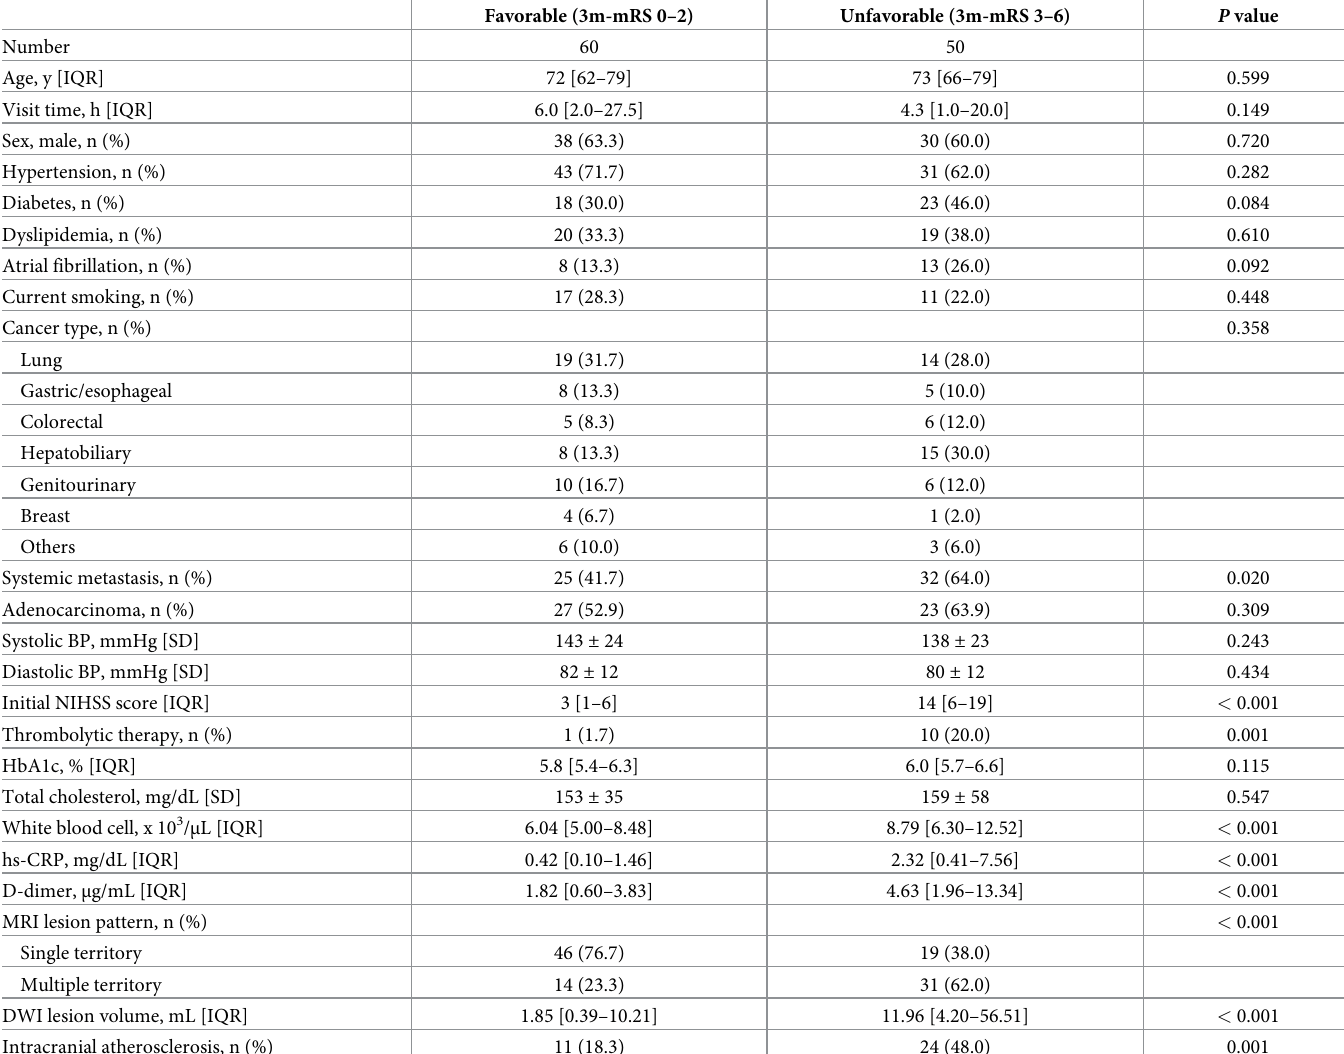
Table 3. Comparisons between patients with favorable and unfavorable outcomes (n =